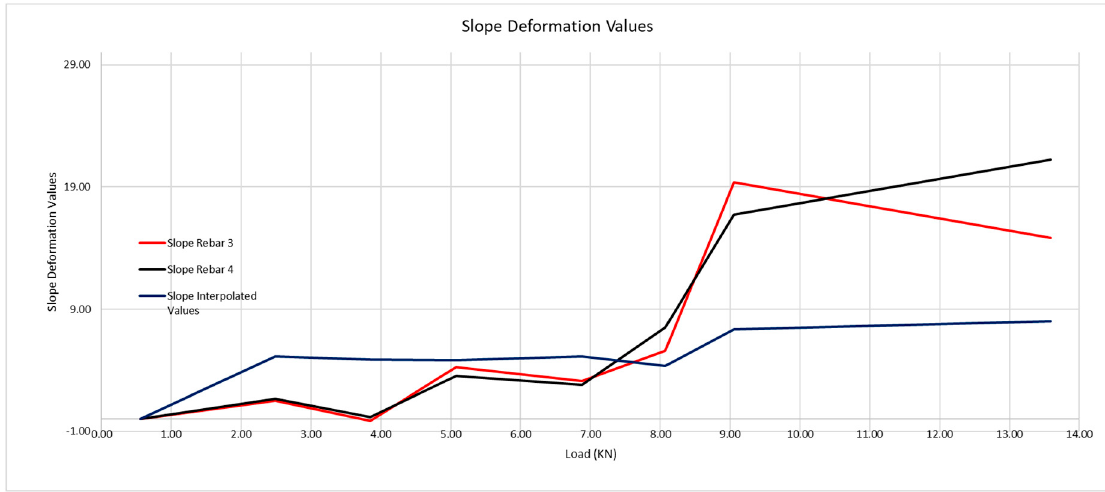
Figure 19. Detail of the first crack forming in the 200 × 300 mm beam.